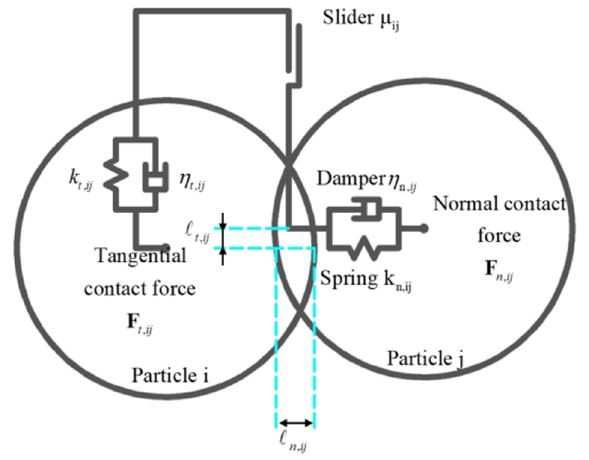
Figure 3. Particle collision